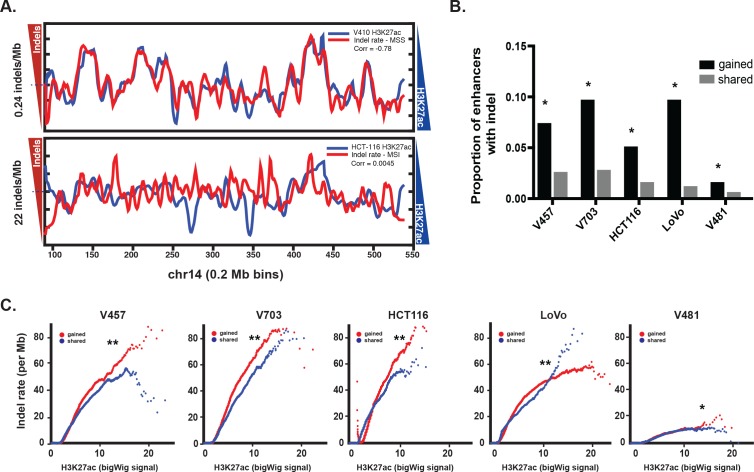
Enrichment of MSI indels in gained enhancers.(A) MSS (top) and MSI (bottom) mutations (red) are overlaid on H3K27ac profiles (blue) of representative MSS (V410) and MSI (HCT-116) lines in 0.2 Mb bins on chromosome 14. Median mutation rates are shown next to left Y axis. The H3K27ac signal is inverted to better show anti-correlation. Pearson correlation values are shown. (B) Proportion of gained enhancers (black) and enhancers shared with normal crypt (grey) with at least one allele-biased indel. *p<1e-10, Z-test for two proportions. (C) Rate of allele-biased indels in gained (red) and shared (blue) enhancers, as a function of H3K27ac signal. **, p<1e-10; *p<0.05, t-test (Figure 2—source data 1).10.7554/eLife.40760.008Figure 2—source data 1.H3K27ac signal and mutation rate for MSS and MSI samples, in 0.5 Mb genomic bins.10.7554/eLife.40760.009Figure 2—source data 2.Indel rate and H3K27ac signal for gained enhancers and enhancers shared with crypt, for 5 MSI cell lines.